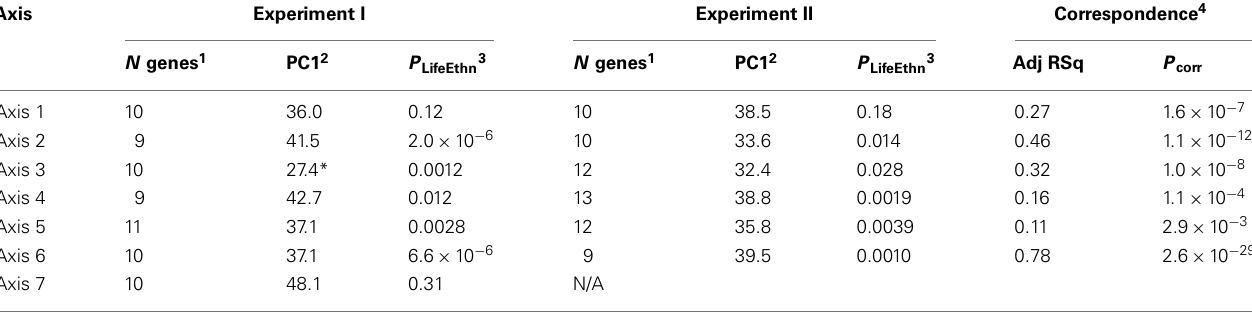
Table 2 | Blood informative transcript